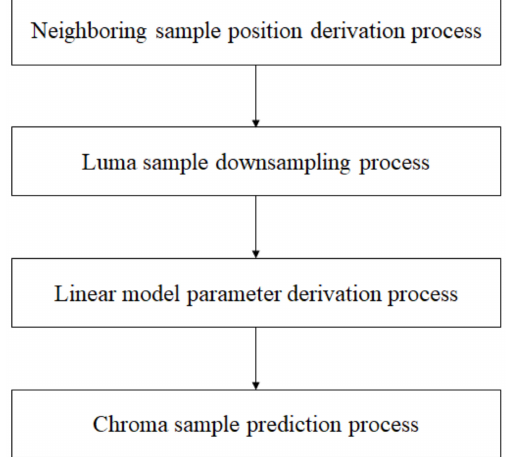
Figure 1. Processing flow chart of the cross-component linear model (CCLM) in the versatile video coding test model